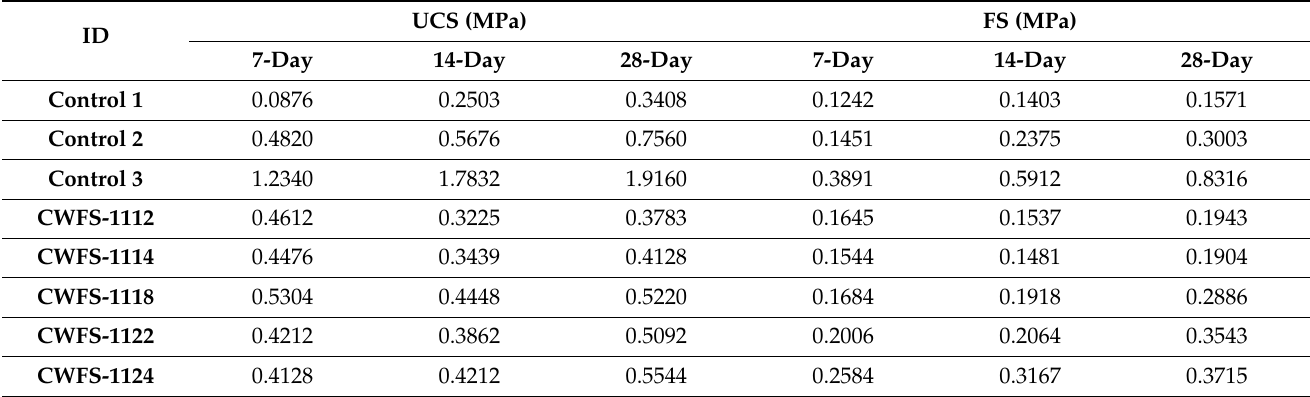
Table A1. Mixing proportion for all variable